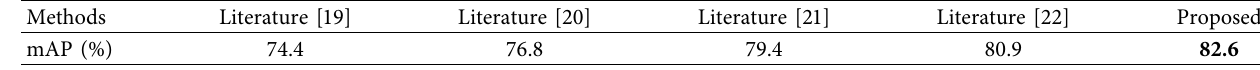
Table 1: Experimental results of PASCAL VOC dataset.